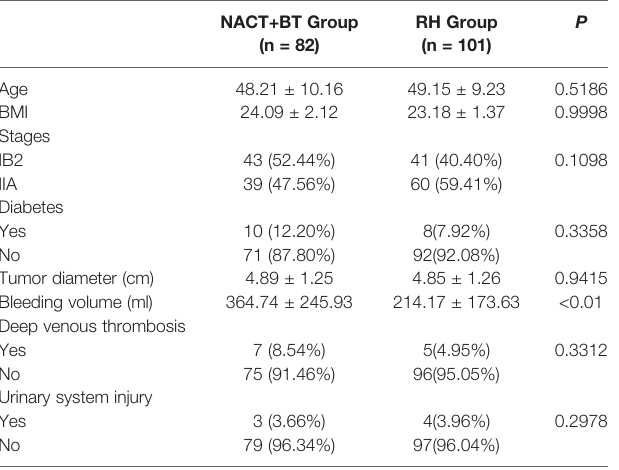
TABLE 1 | Basic demographic and clinical factors in patients with local advanced cervical cancer (LACC).